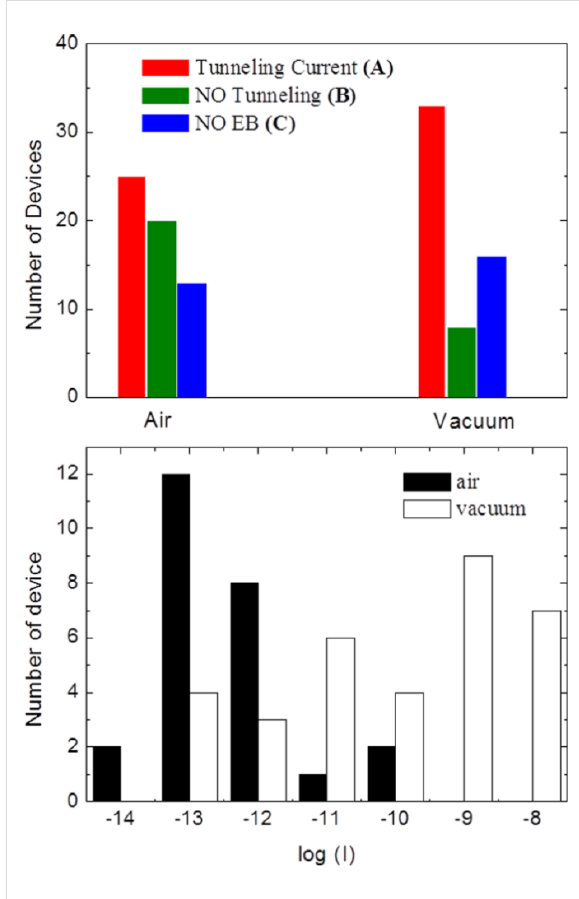
Figure 2: top) Number of measured devices displaying the following behavior: A) sizeable tunneling current ( I > 10 − 13 A @ 1.5 V) after the EB process (red); B) no tunneling current after EB (green); C) no EB for the maximum currents and/or voltages available. Results related to both procedures, in air and under vacuum, are presented. Bottom) Logarithm of the current (in amperes) measured at V = 0.5 V for the devices of group A: the measured current is significantly different if the EB process is carried out in air (black histograms) or under vacuum (white